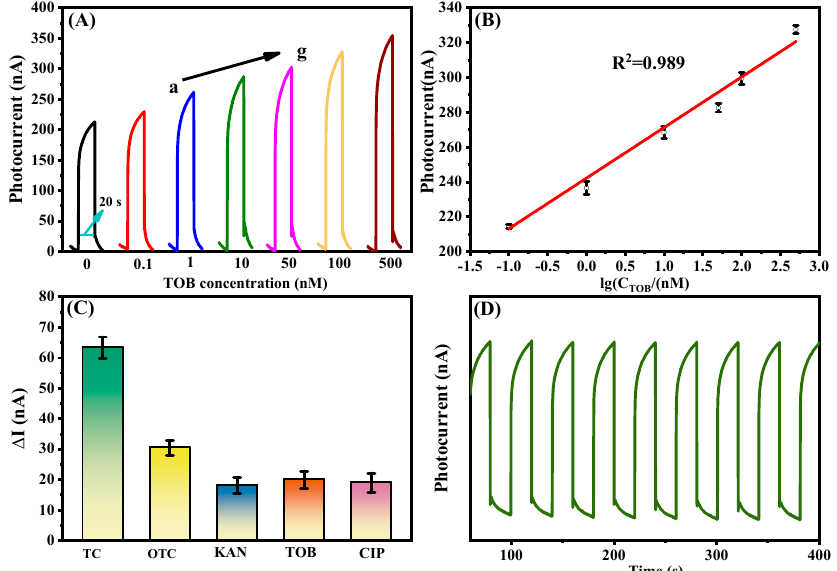
Figure 3. ( A ) Photocurrents of the PEC sensor at various concentrations of TC; ( B ) corresponding calibration curve; ( C ) selectivity; ( D ) stability of the PEC sensor.